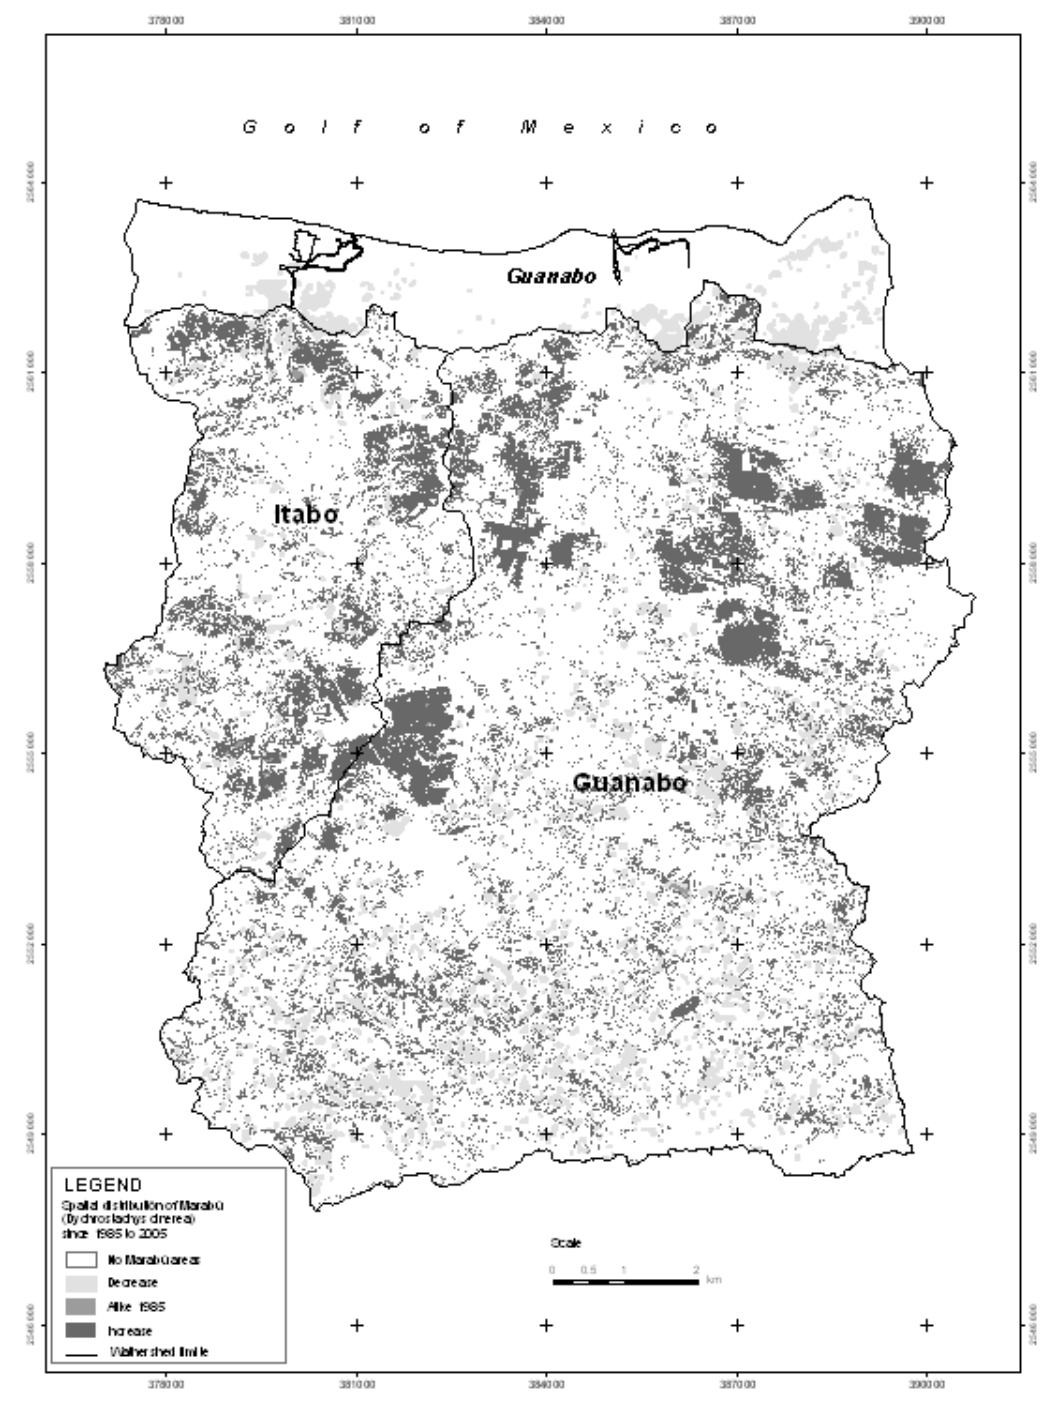
Figure 4. Expansion of Marabú ( Dychrostachys cinerea ) from 1985 to